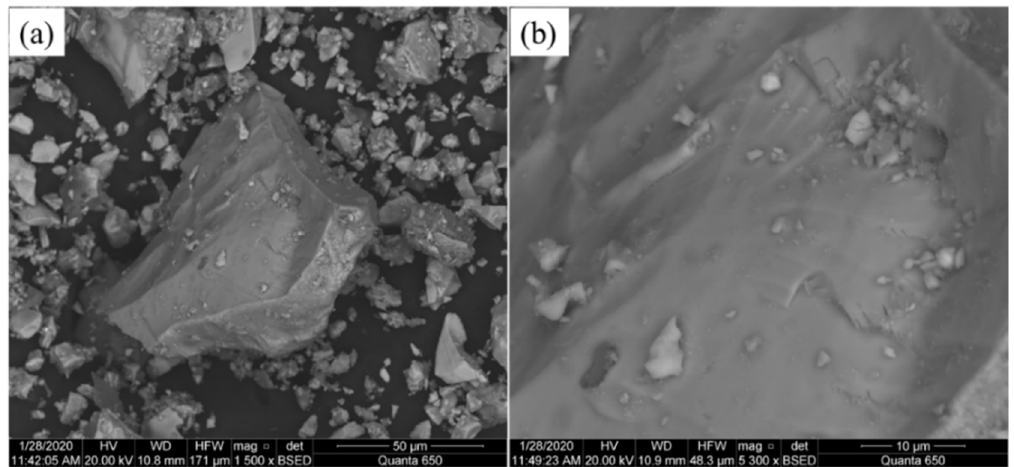
Figure 2. SEM images of the chalcopyrite-bearing ore at ( a ) ×1500 and ( b ) ×5300 magnification. Minerals 2020 , 10 , x FOR PEER REVIEW